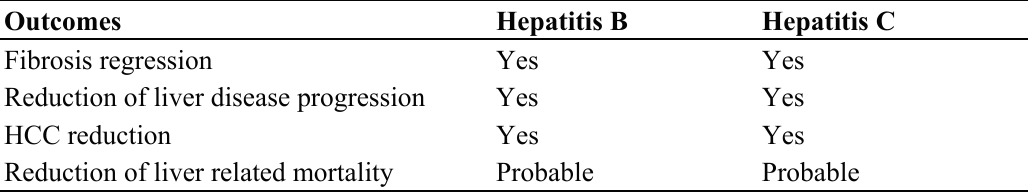
Table 3. Beneficial results of successful antiviral therapy in viral